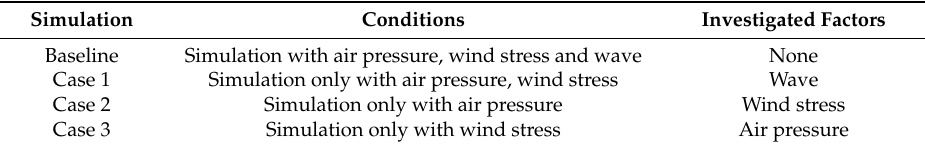
Table 3. Designed numerical experiments for investigating the factors contributing to surge.